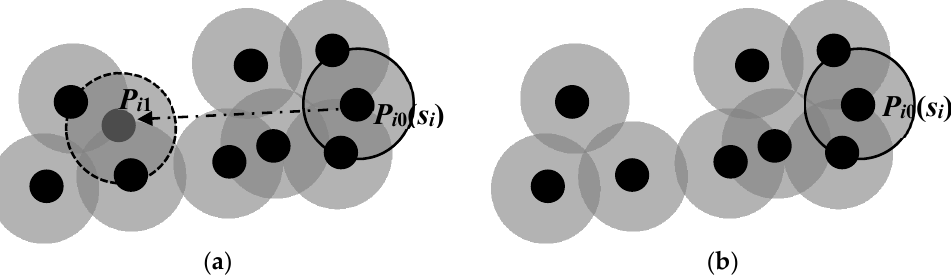
Figure 1. Reduce the number of mobile sensor nodes need to move. ( a ) The movement plan of Sensor s i ; ( b ) Cancellation of the movement plan of s i .